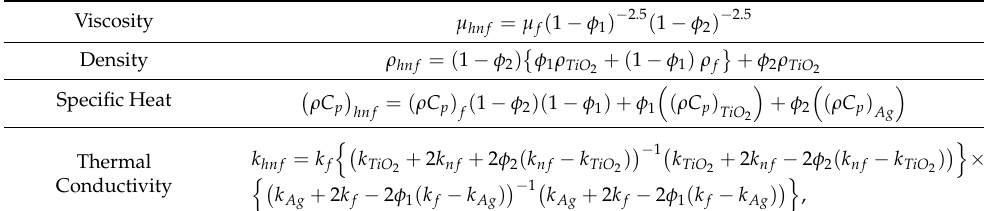
Table 2. Various thermophysical properties of TiO 2 − Ag / Blood are stated as